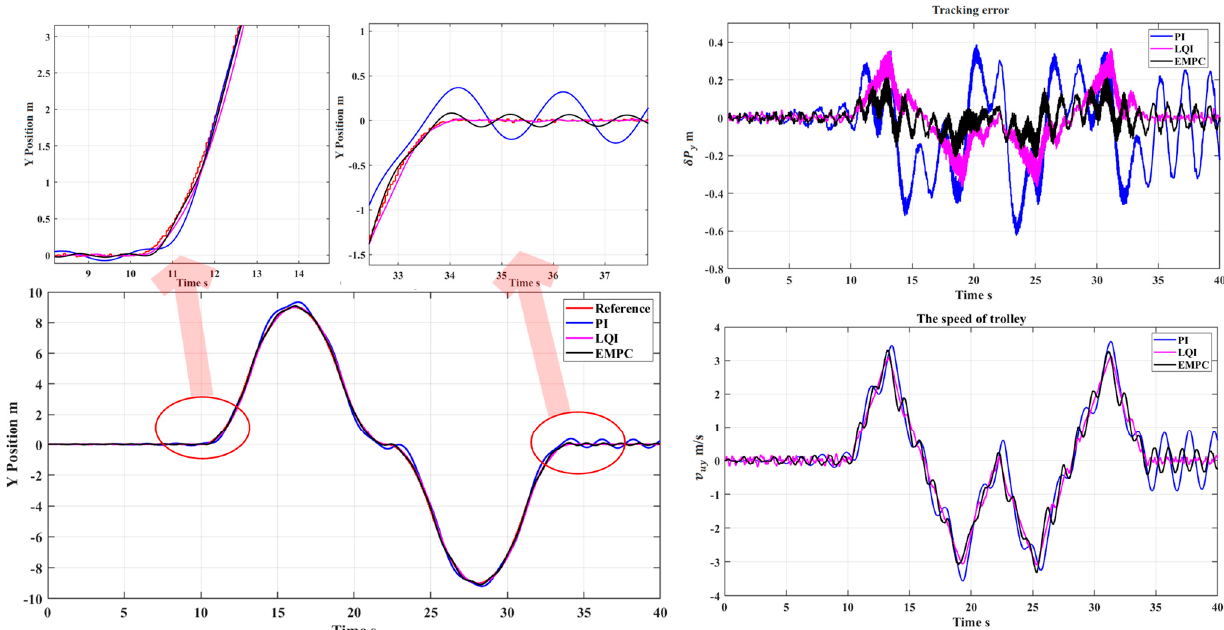
Figure 10. Results of the trolley tracking desired path two. The figures present the following results: the results of trolley tracking desired path one in the Y direction; tracking errors δ P y between the trolley’s position and the desired position along path two in the Y direction; the trolley speed v uy of tracking path two.